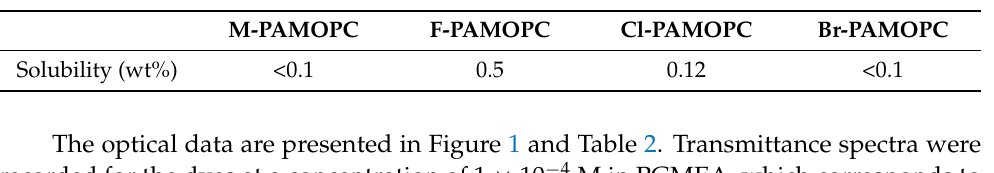
Table 1. The solubility of the synthesized materials in PGMEA